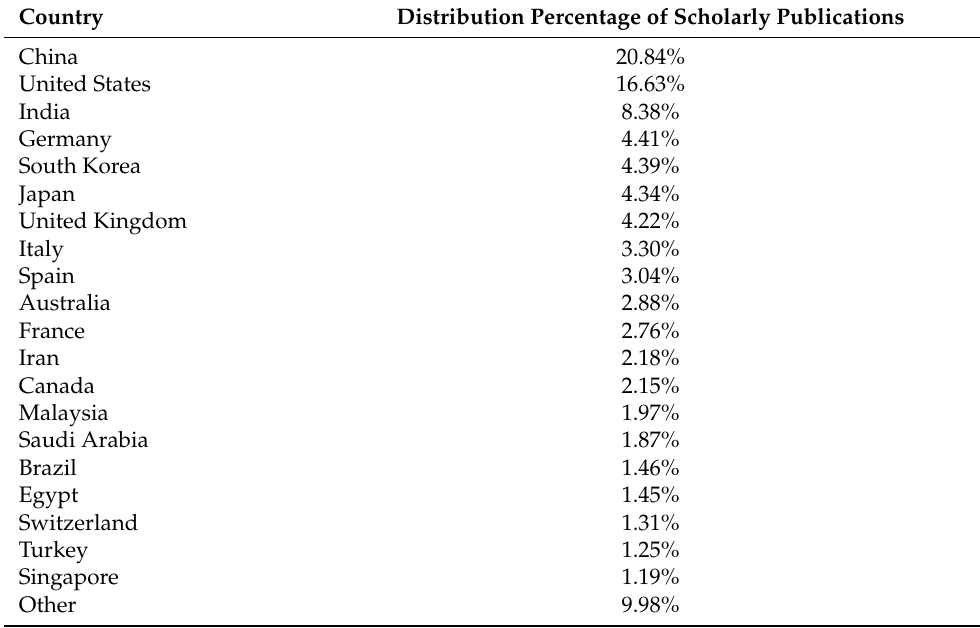
Table 3. Percentage distribution of scholarly publications by country. Country Distribution Percentage of Scholarly